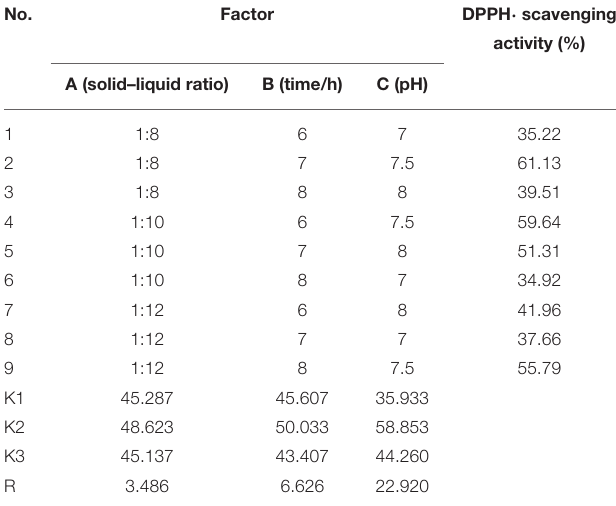
TABLE 1 | Orthogonal array design matrix L 9 (3 3 ) and results for optimizing the hydrolysis conditions of Flavourzyme. No. Factor DPPH ·